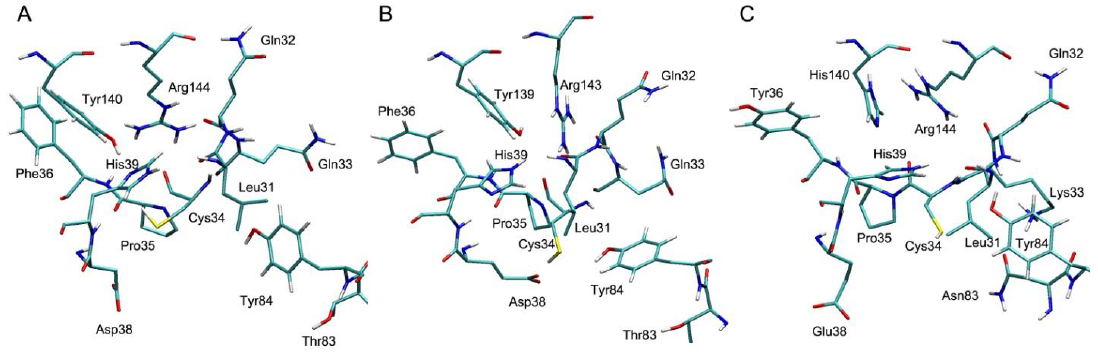
Figure 4. The structures of Sudlow site II of human ( A ), bovine ( B ) and rat ( C ) albumin.